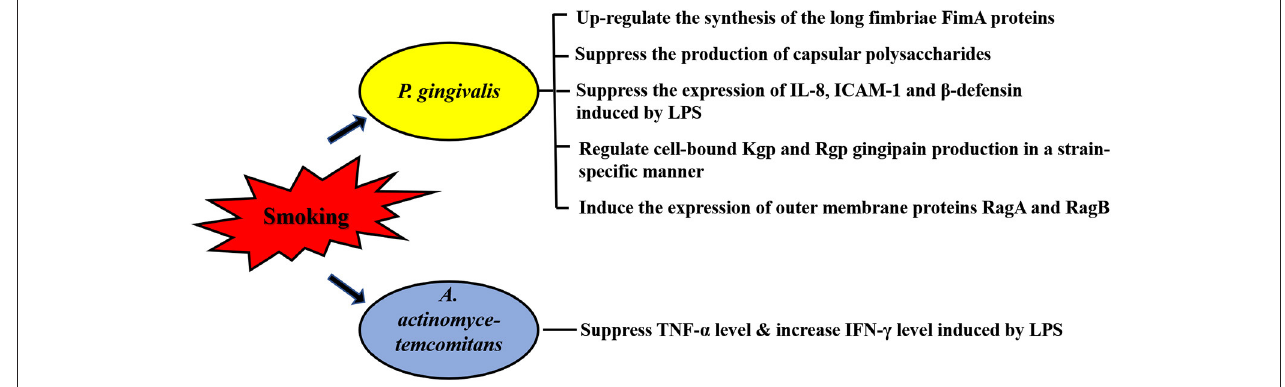
FIGURE 1 | Effects of smoking on virulence factors of periodontopathogens. Expression or function of multiple virulence factors of P. gingivalis are affected by smoking, including the long fimbriae FimA, capsular polysaccharides, outer membrane proteins RagA and RagB, Kgp and Rgp gingipain and lipopolysaccharide (LPS). The immune response caused by LPS of A. actinomycetemcomitans is also influenced by smoking. Intercellular adhesion molecule-1,